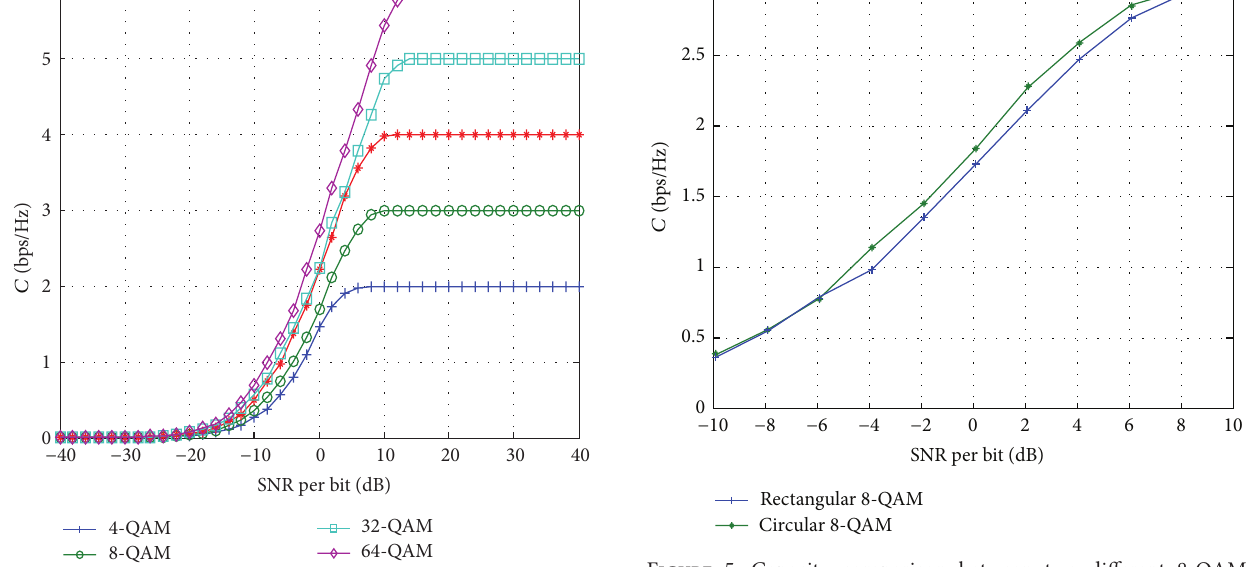
Figure 5: Capacity comparison between two different 8-QAM signal